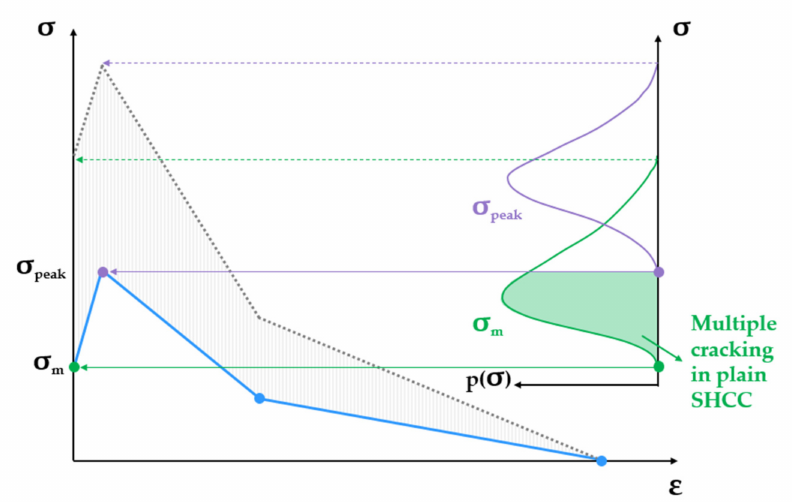
Figure 5. Schematic representation of the probability distribution of the matrix strength and tensile strength of SHCC and the minimum parameter values defining the tensile behavior of plain SHCC according to the blue multilinear law. The representation refers to the post-elastic